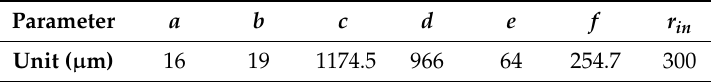
Table 2. Dimensional parameters of the Text layer.